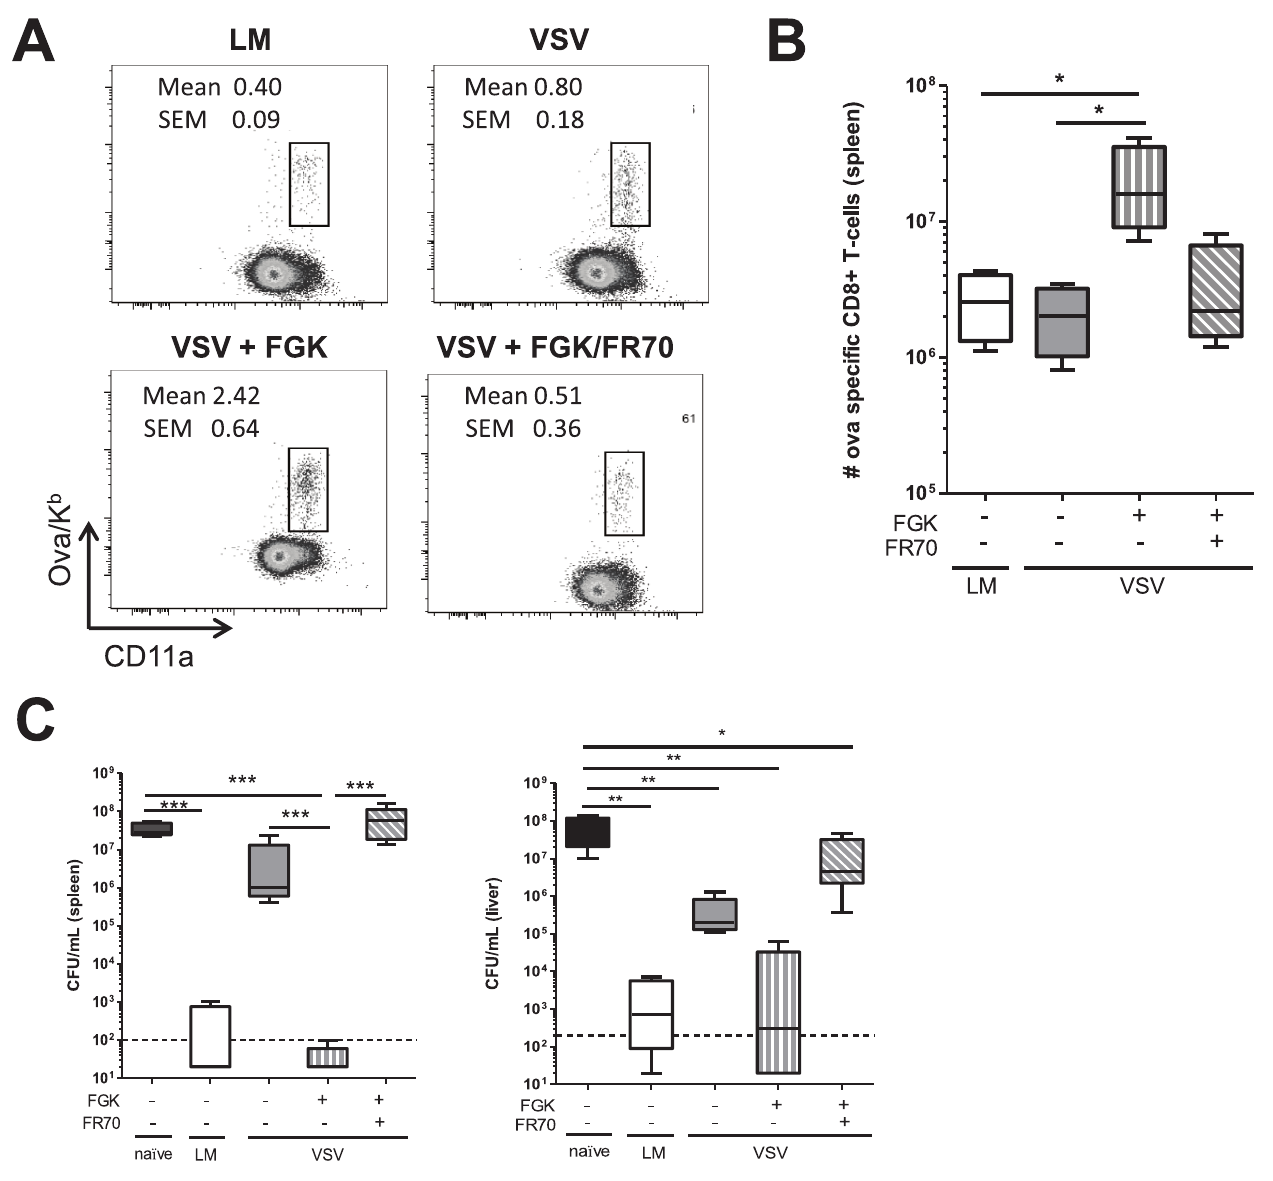
Figure 6. Enhancement of CD8 + T cell response by FGK4.5 treatment during VSV infection is dependent on CD70. C57BL/6 mice were left uninfected, or i.v. infected with 2 6 10 3 cfu LM-ova, or with 2 6 10 5 pfu VSV-ova alone, or 2 6 10 5 pfu plus 100 m g FGK4.5 treated i.p. one day after infection, or 2 6 10 5 pfu VSV-ova plus 100 m g FGK4.5 one day post infection and 300 m g FR70, a blocking CD70 mAb, on days 2 1, + 1, and + 3 relative to infection. The magnitude of the Ova/K b -specific memory CD8 + T cell population in the (A) peripheral blood and in the (B) spleen was quantified